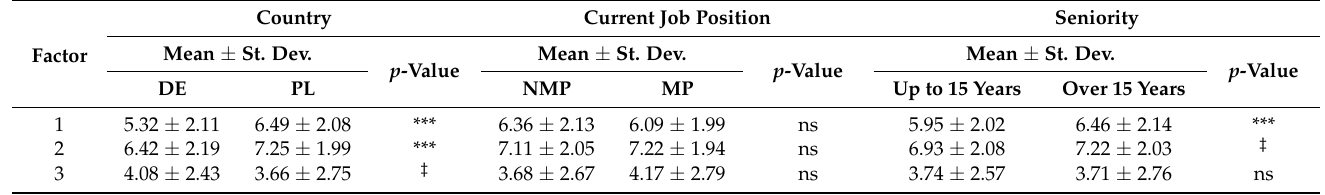
Table 7. Differentiation of opinions concerning work in the nursing profession due to selected factors. Country Current Job Position Seniority Mean ± St. Dev. Mean ± St. Factor p -Value